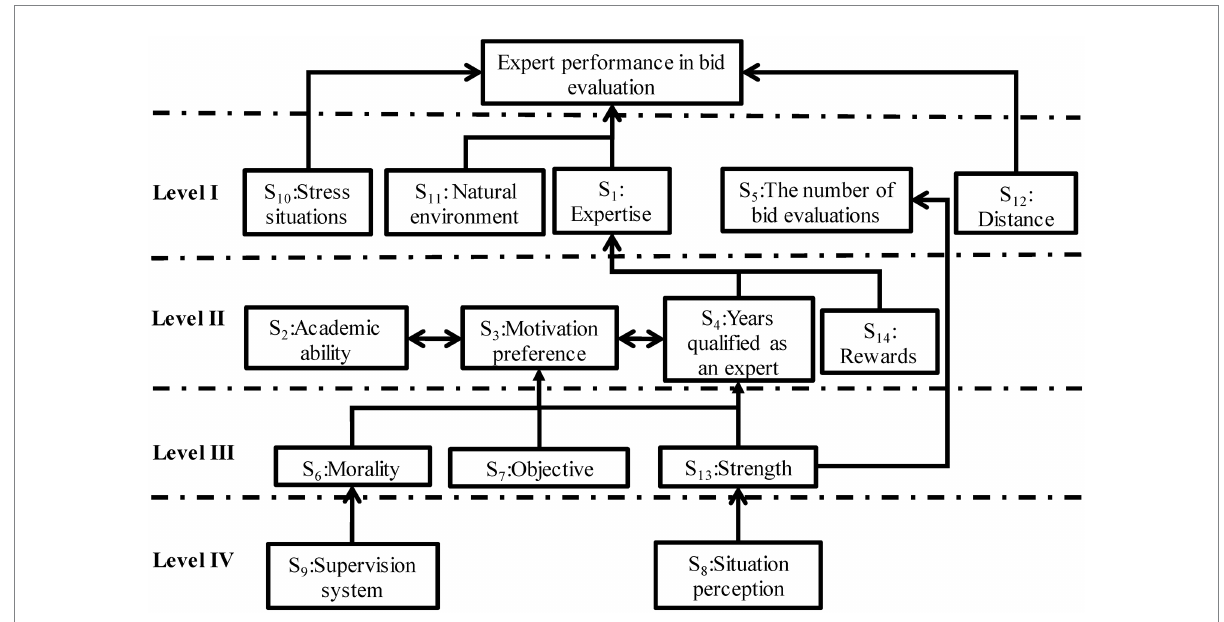
FIGURE 3 Diagram of expert performance factors in bid evaluation.